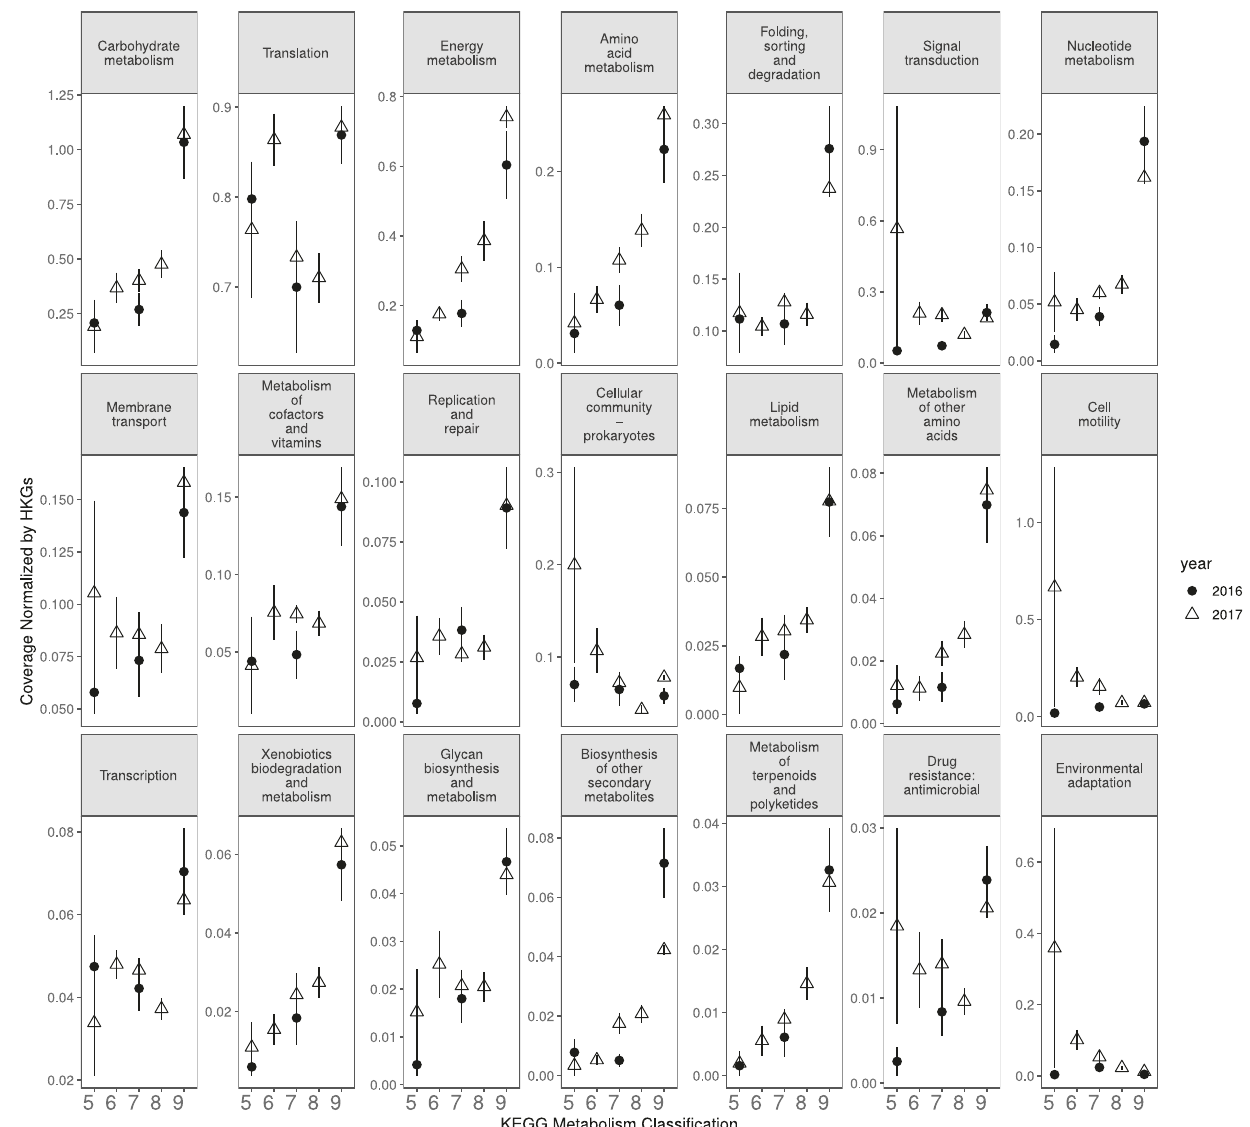
Fig. 5 | 2016(circle)and 2017(triangle) switchgrass leaf transcript dynamicsof KEGG metabolism classi fi cations to the 40 focal MAGs. The y-axis is scaled for each classi fi cation. Sample sizes are provided in Table 1 and included 22 and 56